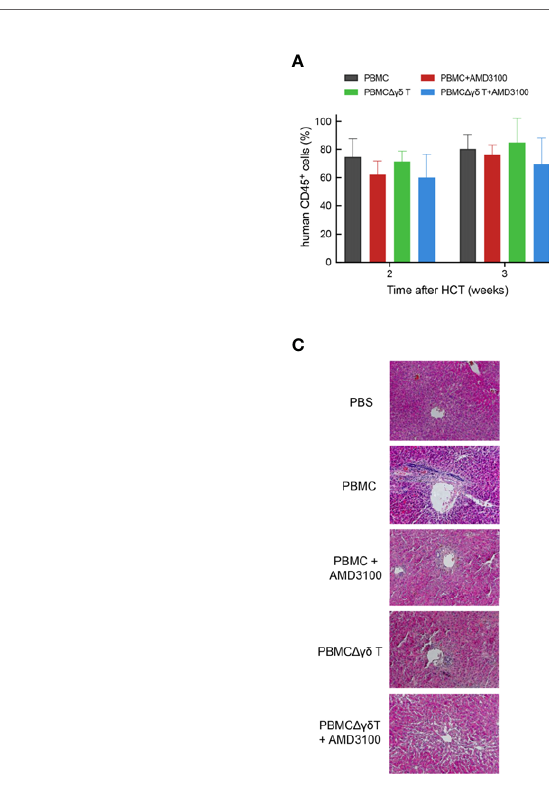
FIGURE 7 | Impacts of gd T cells and inhibitor of CXCR4 signaling on the onset of severe aGVHD and the survival time in humanized mice. The proportion of human CD45-positive cells was detected by fl ow cytometry at 2 and 3 weeks in mouse peripheral blood after injection with human PBMCs, PBMCs plus AMD3100, PBMC Dgd T cells, and PBMC Dgd T cells plus AMD3100 (A) . The onset time of severe aGVHD among each group were depicted (B) . Histopathological examination was performed on biopsy specimens of liver obtained from transplanted mice (C) . The survival time among each group were depicted (D) . n = 4, ** P < 0.01, * P < 0.05, other P values are shown on the graphs.